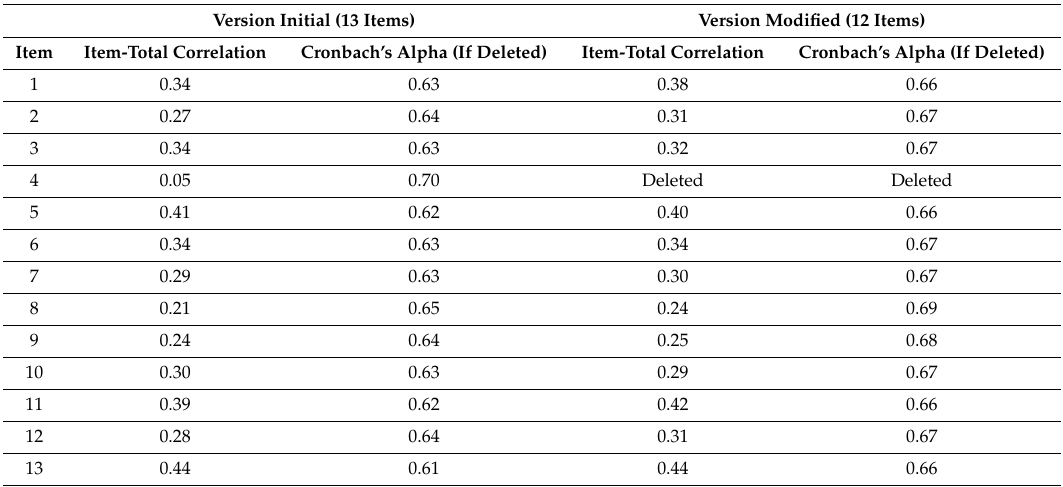
Table 3. Internal consistency reliability of the Attitude towards Pressure Ulcers (Spanish version).